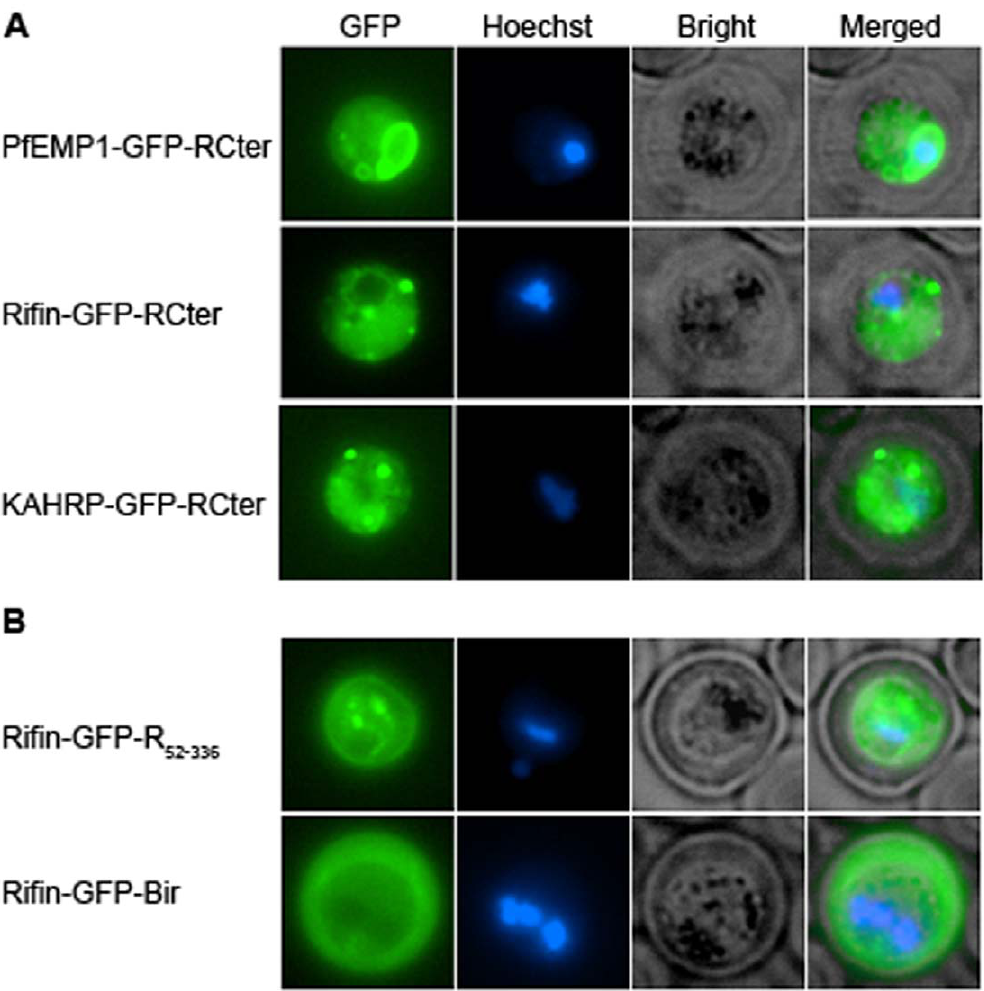
Figure 3. The C-terminus of rifin prevented GFP export. Trophozoite-stage parasites were imaged as described for Fig. 2. ( A ) Parasites expressing GFP chimeras containing the C-terminus of rifin at the carboxy terminus and the N-terminus of PfEMP1 (PfEMP1-GFP-RCter), rifin (Rifin- GFP-RCter) or KAHRP (KAHRP-GFP-RCter) at the N-terminus. ( B ) Parasites expressing GFP chimeras with the N-terminus of rifin upstream and the remaining region of rifin (Rifin-GFP-R 52-336 ) or a bir protein (Rifin-GFP-Bir)